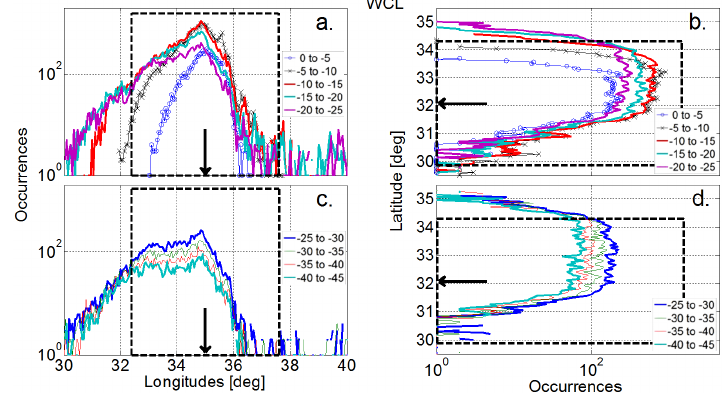
Figure 1. Distribution of peak currents during WCL days. Data are plotted as a function of longitudes ( a and c ) and latitudes ( b and d ). Distributions are calculated for steps of 5kA in peak current intensities. ( a and b ) are for peak currents between 0 and − 25kA and ( c and d ) present the range between − 25 and − 45kA. Black boxes mark a distance of 250km from the center of the study region which is marked by black arrows. Absolute currents larger than 45kA are not shown. Table 1. Criteria used for classification of synoptic